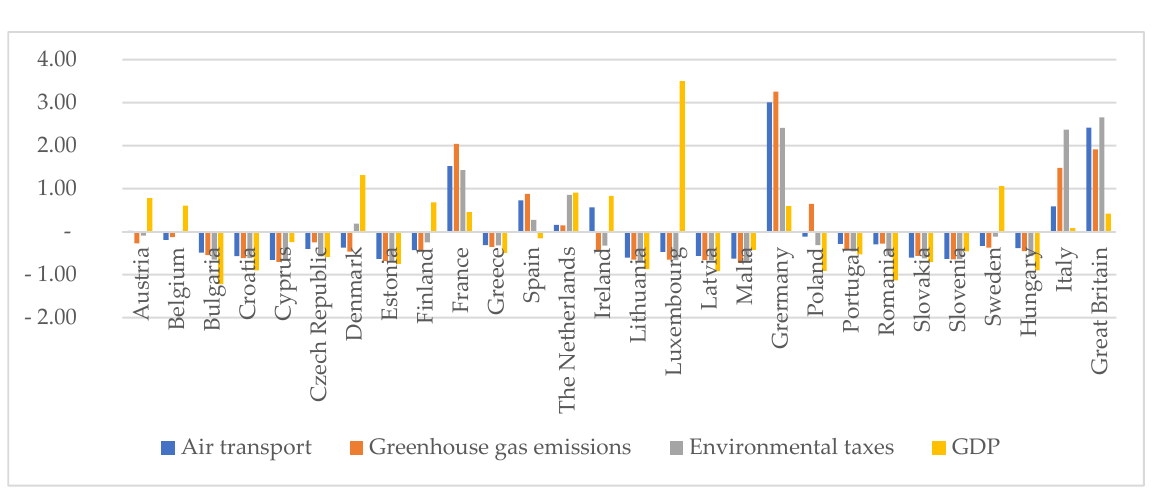
Figure A6. Distribution of European Union countries determined using Perkal index in 2011. Source: Reproduced from [16], Eurostat: 2009—2018.